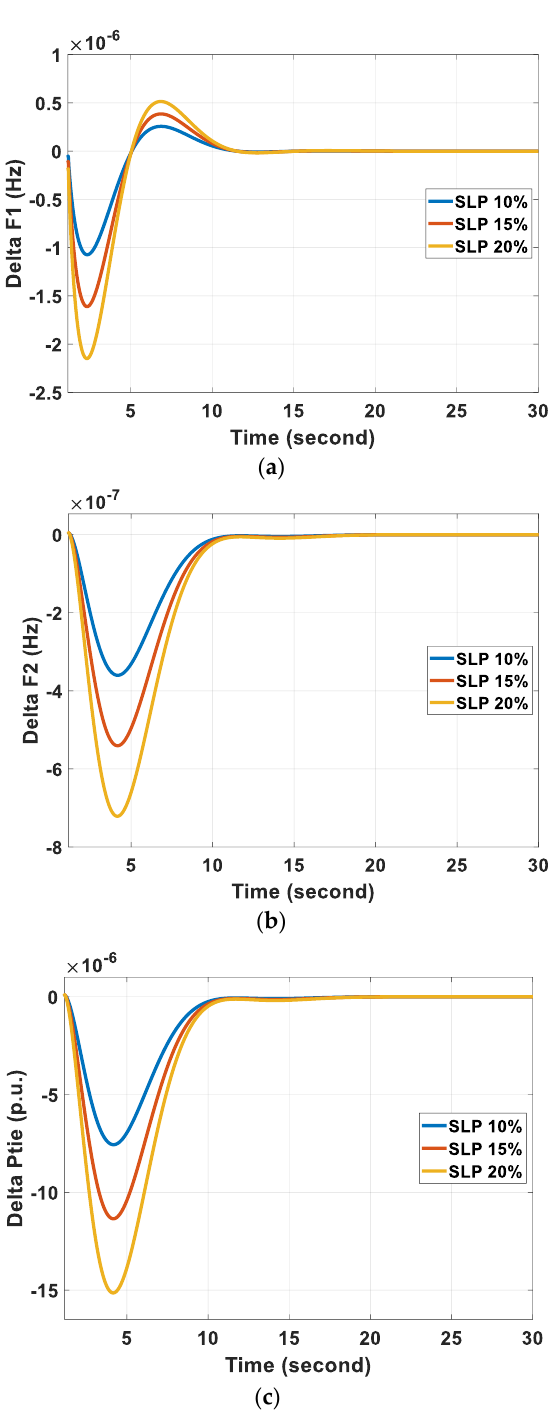
Figure 11. Dynamic response for small SLP based on ULC-fuzzy PIDF controller: ( a ) ΔF 1 , ( b ) ΔF 2 and ( c ) ΔP tie .